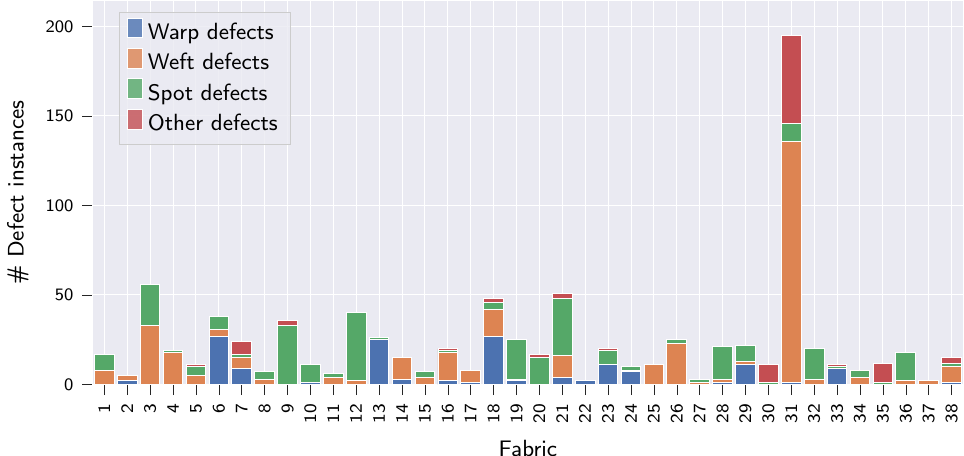
1234567891011121314151617181920212223242526272829303132333435363738